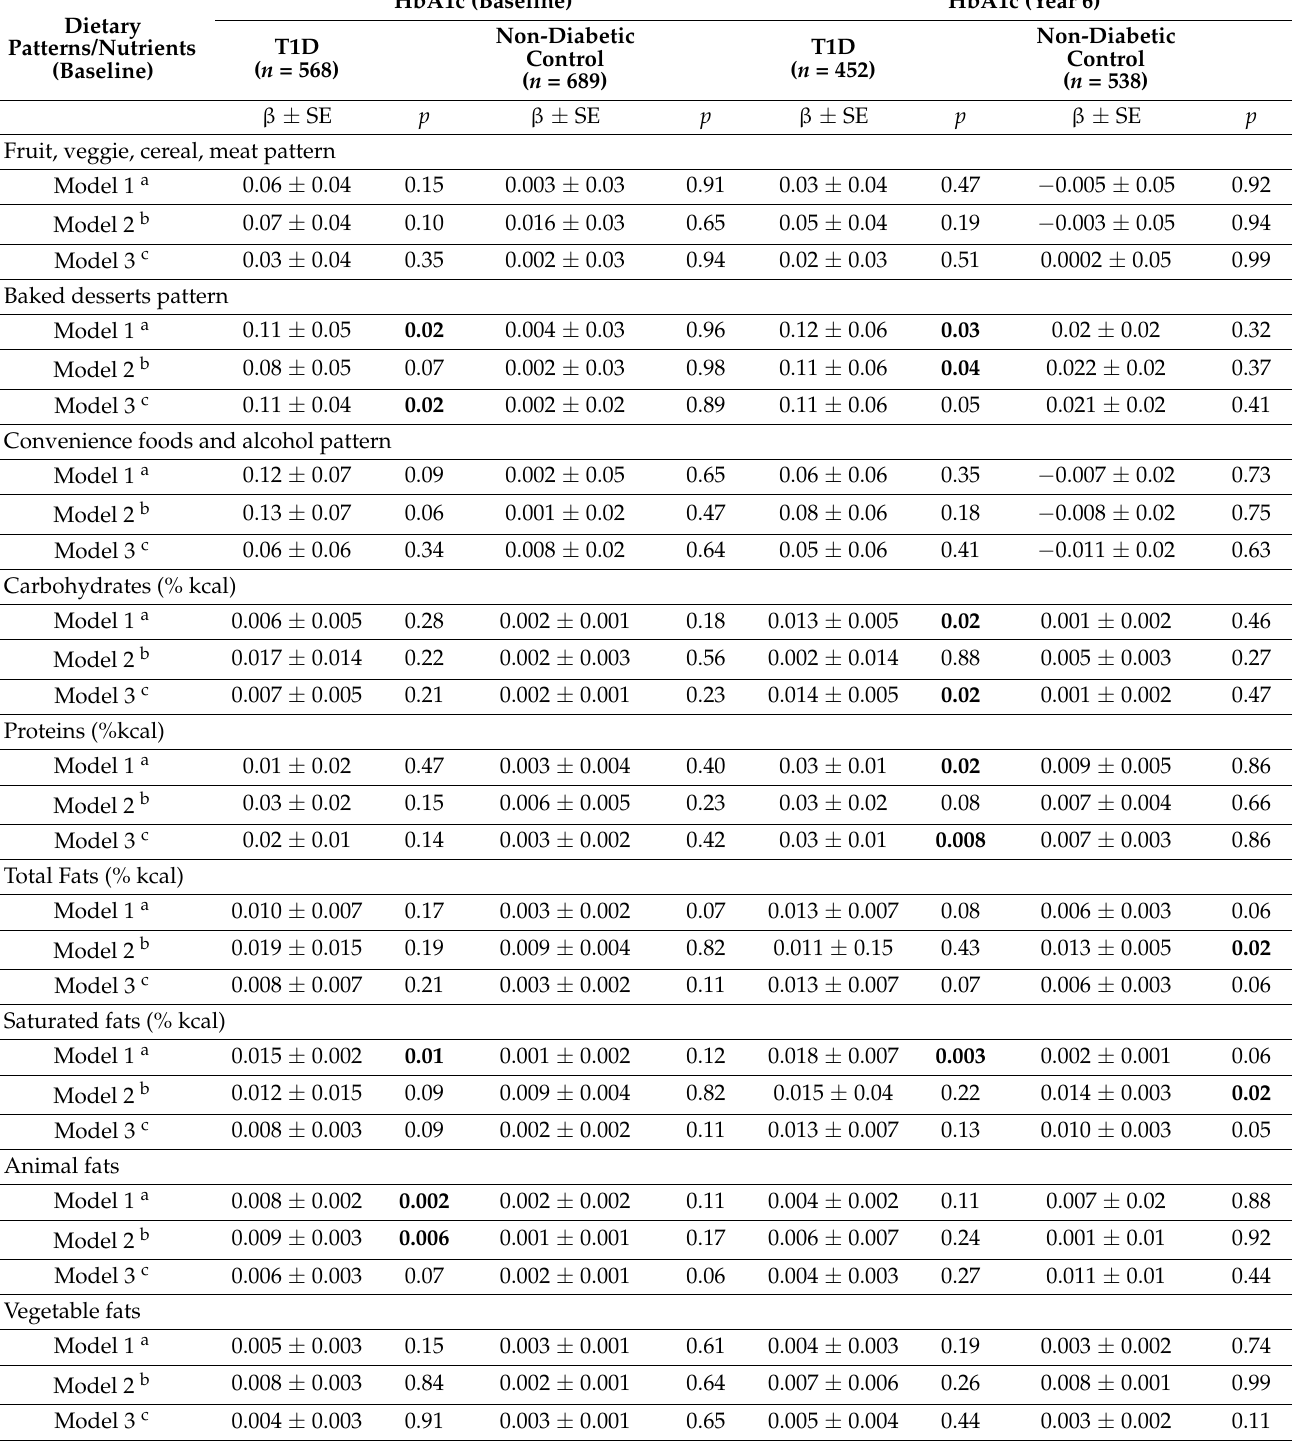
Table 2. Associations of dietary patterns and macronutrients with HbA1c in adults with and without type 1 diabetes (T1D). Dietary